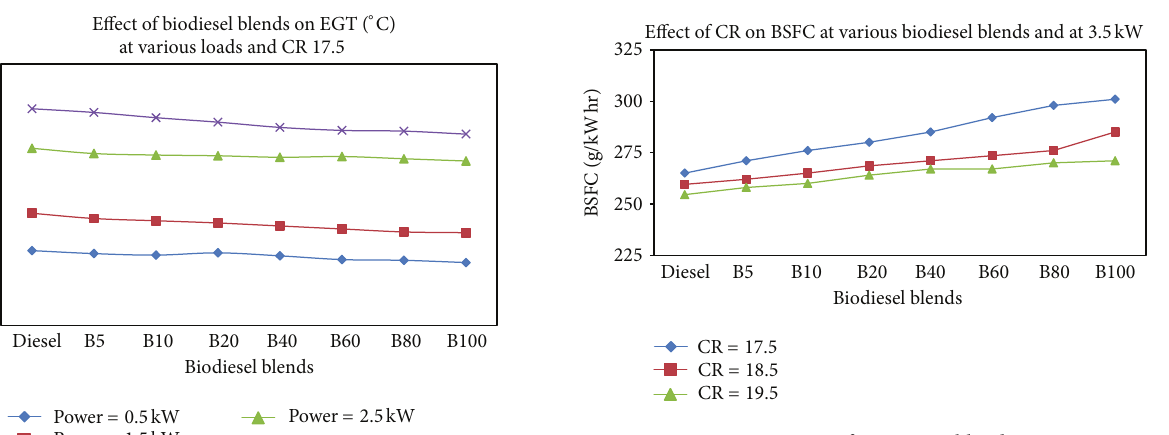
Figure 10: Variation in BSFC for various blends at compression ratios 17.5, 18.5, and 19.5.